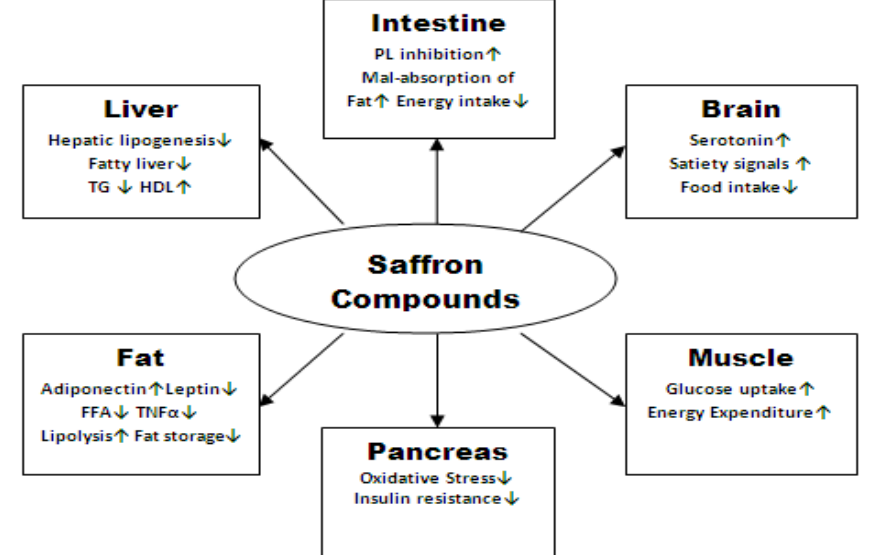
PL: Pancreatic lipase; TG: Triglyceride; HDL: High-density lipoprotein; FFA: Free fatty